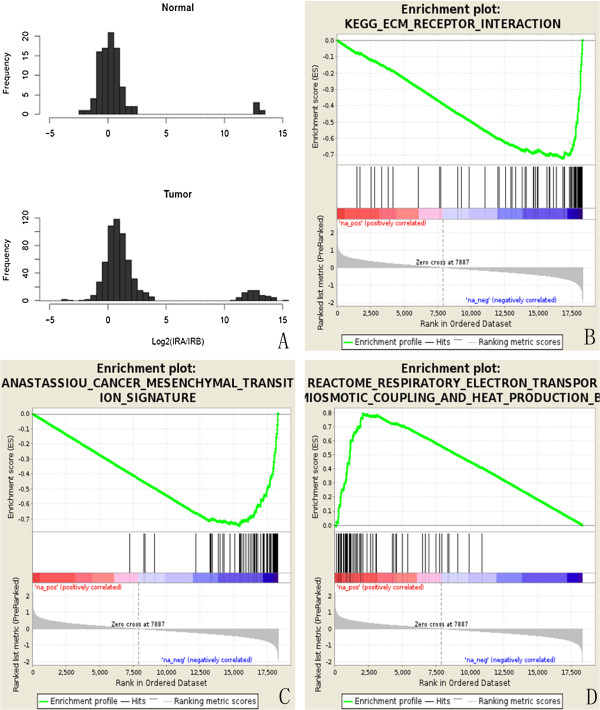
IR-A/IR-B mRNA ratio in NSCLC and the differentially expressed genes associated with the ratio of IR-A/IR-B mRNA. A. Distribution of the IR-A/IR-B mRNA ratio among the NSCLC and the adjacent normal lung specimens. According to the distribution of IR-A/IR-B mRNA ratio in the adjacent normal lung (the top panel), log2(8) (i.e., 3) was selected as the cutoff value to stratify the subjects into two groups: high IR-A/IR-B ratio (HIR) and low IR-A/IR-B ratio (LIR). B-D. Gene set enrichment analysis (GSEA) of the differentially expressed genes in NSCLC patients with HIR and LIR. GSEA enrichment plots showing that ECM (B) and EMT (C) signaling were down-regulated (p < 0.001, respectively) in LUSC samples with HIR. Additionally, the oxidative phosphorylation pathway was highly enriched in the LUSC samples with HIR (D).